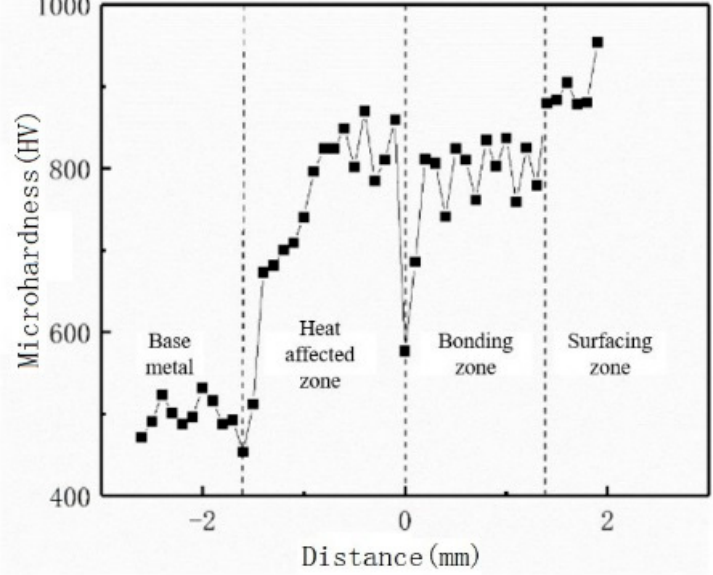
Figure 6. Micro-hardness map from the surfacing layer of the sample to the base metal.